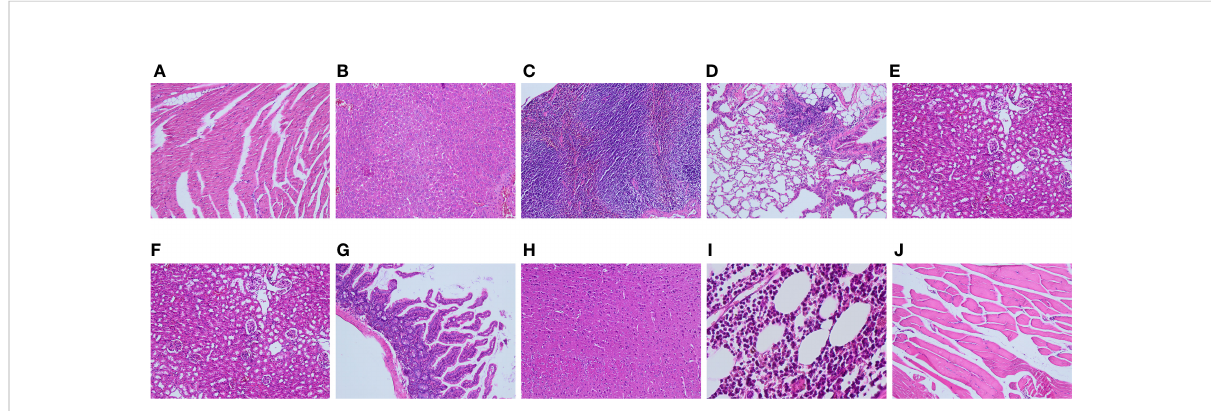
FIGURE 2 Tissue and organ pathology of mice injected with 1.0 mCi of 68 Ga-DOTA-IBA (high dose group) for 4 weeks at different magni fi cations [ (A) : heart; (B) : liver; (C) : spleen; (D) : lung; (E) : kidney; (F) : stomach; (G) : intestine; (H) : brain; (I) : bone marrow; (J) : muscle)].